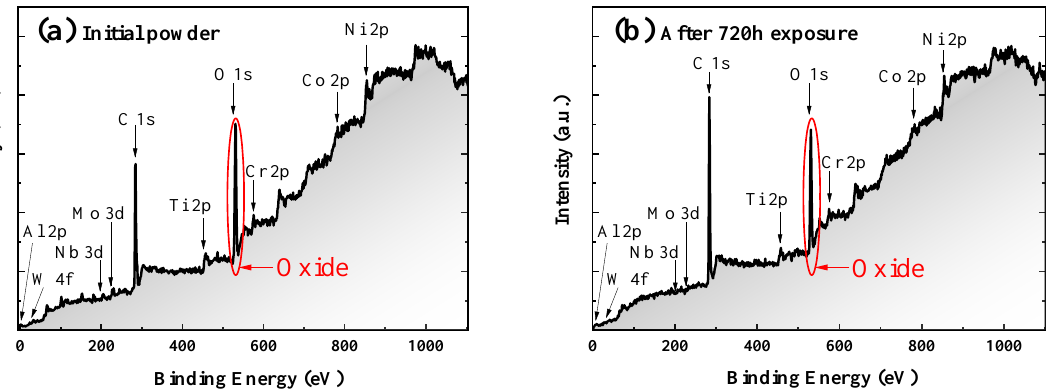
Figure 5. The overall XPS spectra of ( a ) the initial powder and ( b ) the powder after 720 h exposure.